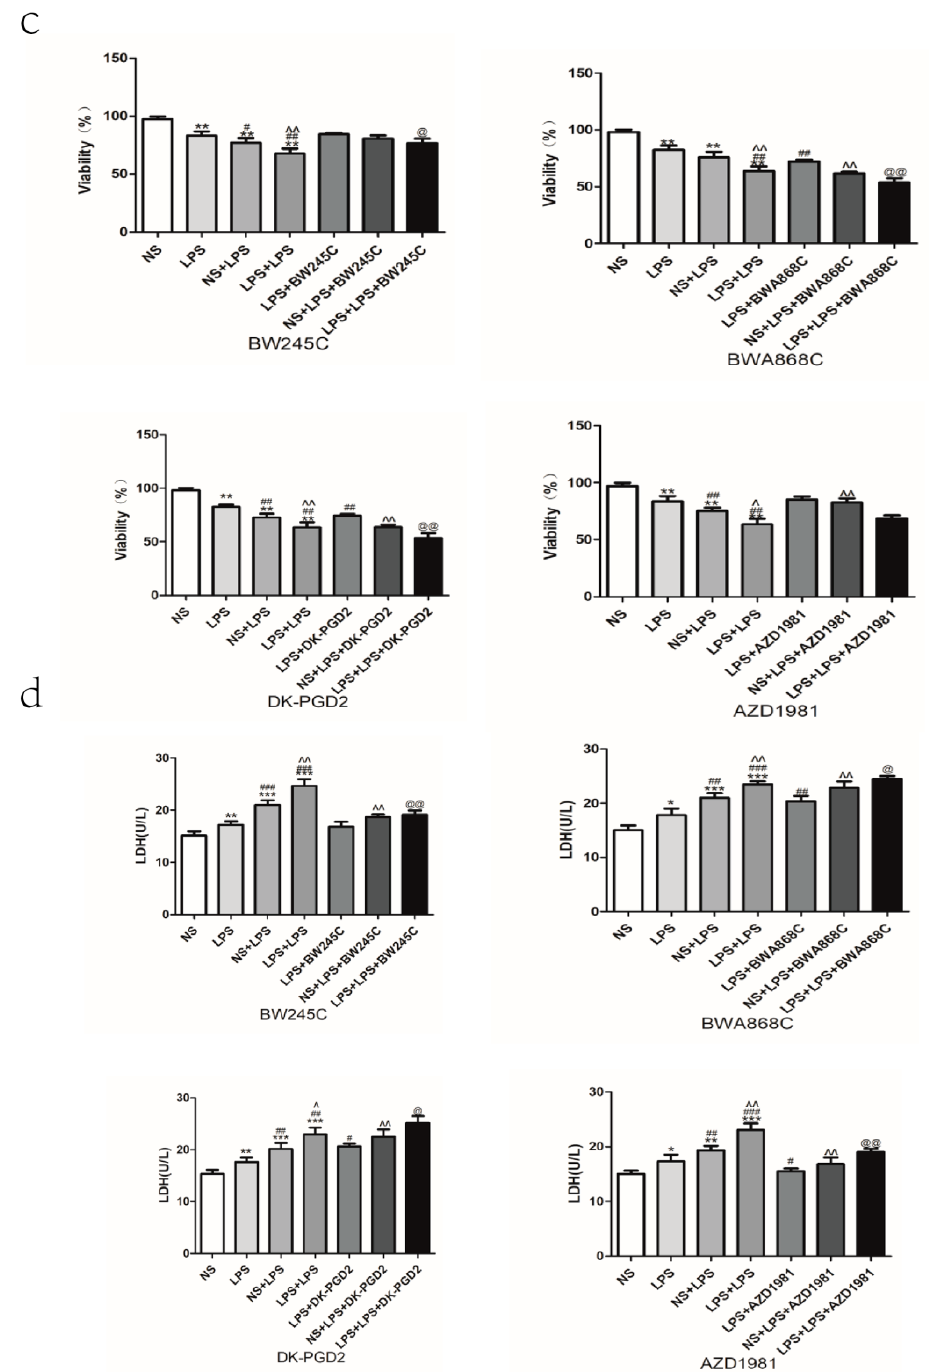
Figure 9. Effect of DP agonist or antagonist on the neuron viability and the LDH leakage in LPS- treated primary neurons of offspring from prenatal inflammation exposure: ( a ) Effect of DP agonists and antagonists on the changes of neuronal viability caused by LPS detected by the method of MTT. ( b ) The change of the LDH leakage rate intervened with the DP agonists and antagonists. ( c ) Change of neuronal viability intervened with the DP agonists and antagonists in each group. ( d ) The change of LDH leakage rate intervened with the DP agonists and antagonists in each group. Data are mean ± SEM, n = 6. (* p < 0.05, ** p < 0.01, *** p < 0.001 vs. NS group, # p < 0.05, ## p < 0.01, ### p < 0.001 vs. LPS group, ^ p < 0.05, ^^ p < 0.01 vs. NS + LPS group, @ p < 0.05, @@ p < 0.01 vs. LPS + LPS group). Compared with NS group, the neuron viability was clearly decreased in the LPS, NS + LPS, and LPS + LPS groups ( p < 0.05 and p < 0.01). The neuron viability was decreased